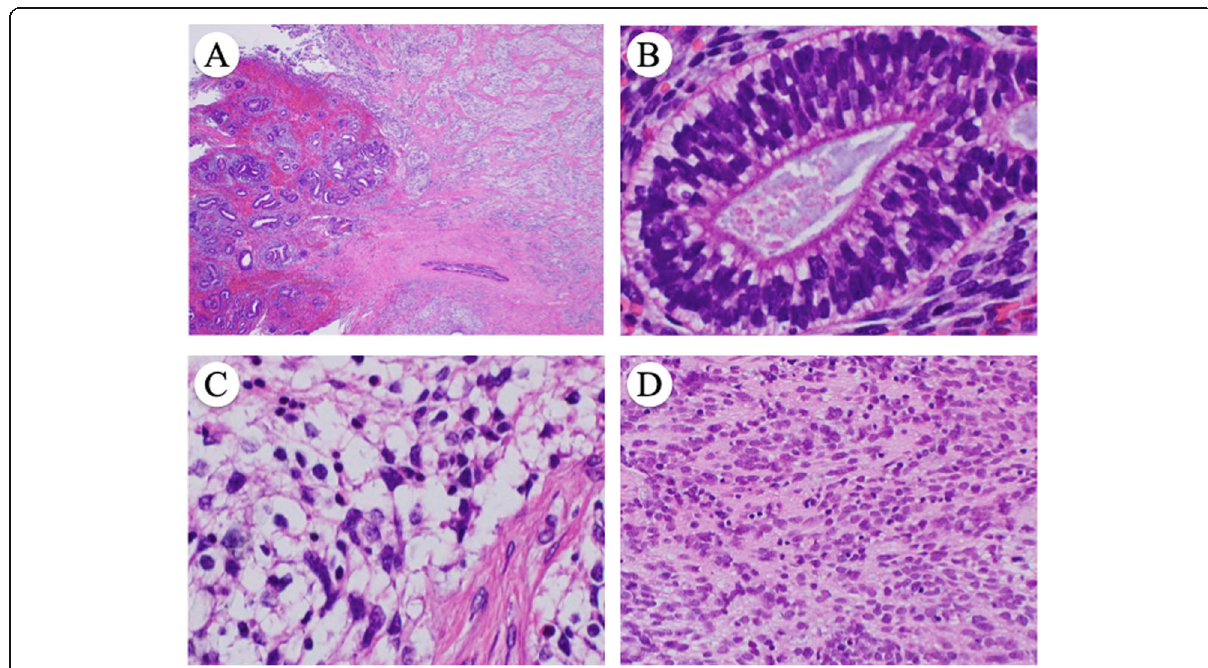
Fig. 2 a Abrupt transition between carcinosarcomatous (left) and neuroectodermal (right) components (magnification ×100). b Immature epithelial gland (magnification ×400). c Neuroectodermal tissue (magnification ×400). d Small blue cells with neuroendocrine differentiation (magnification ×200)